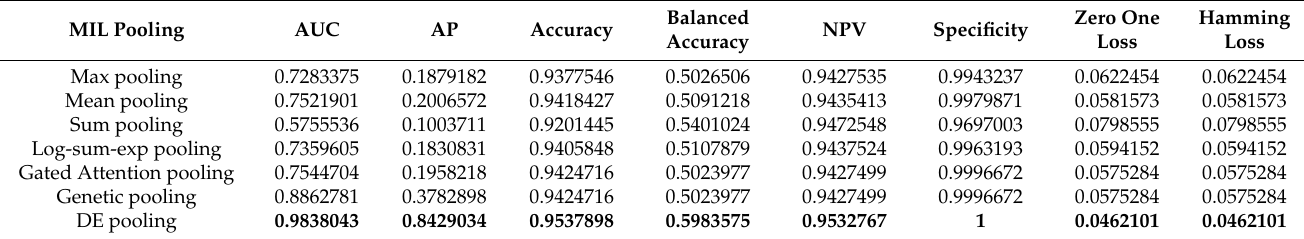
Table 1. Results (architecture = AMI-Net; dataset =